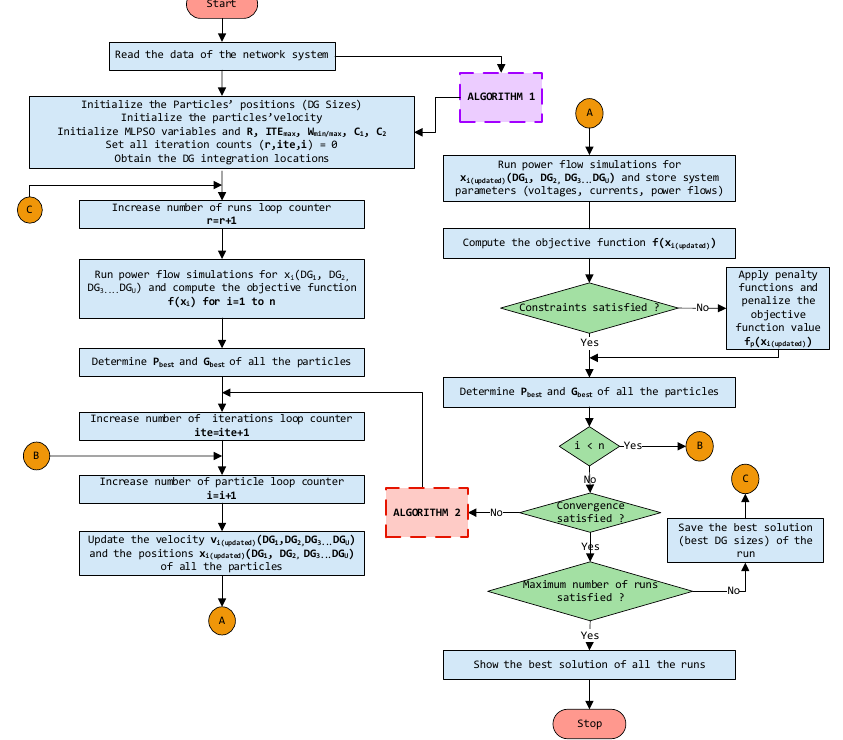
Figure 4. The complete flow chart of the MLPSO algorithm.